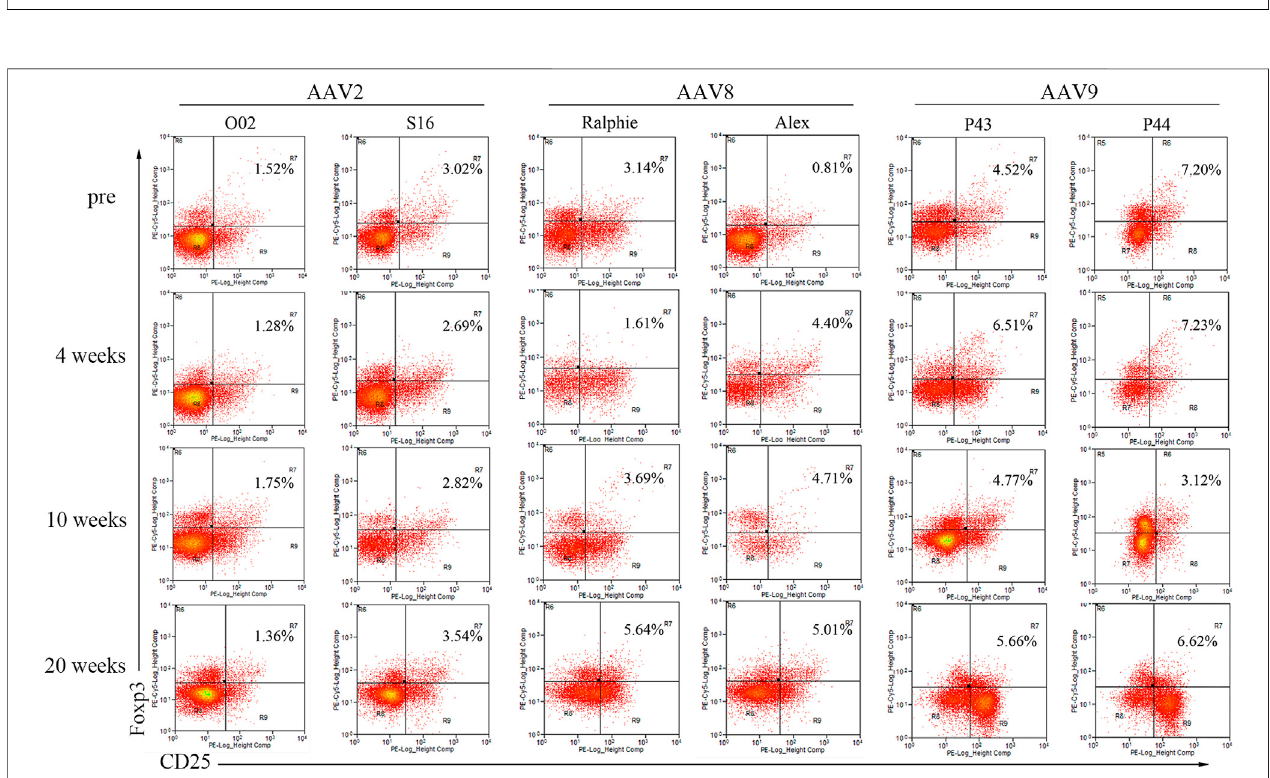
FIGURE 6 | The pro fi le of T regulatory cells in canine PBMCs after administration of varying AAV vector serotypes. PBMCs, separated from the whole blood of hemophilia dogs that were injected with AAV2, AAV8 or AAV9 vectors at a dose of 1 × 10 12 vg/kg, welacbre stained with CD4, CD25 and Foxp3 antibodies, and then analyzed by Flow Cytometry. The percentage of Treg cells (CD4 + CD25 + Foxp3 + ) was shown.